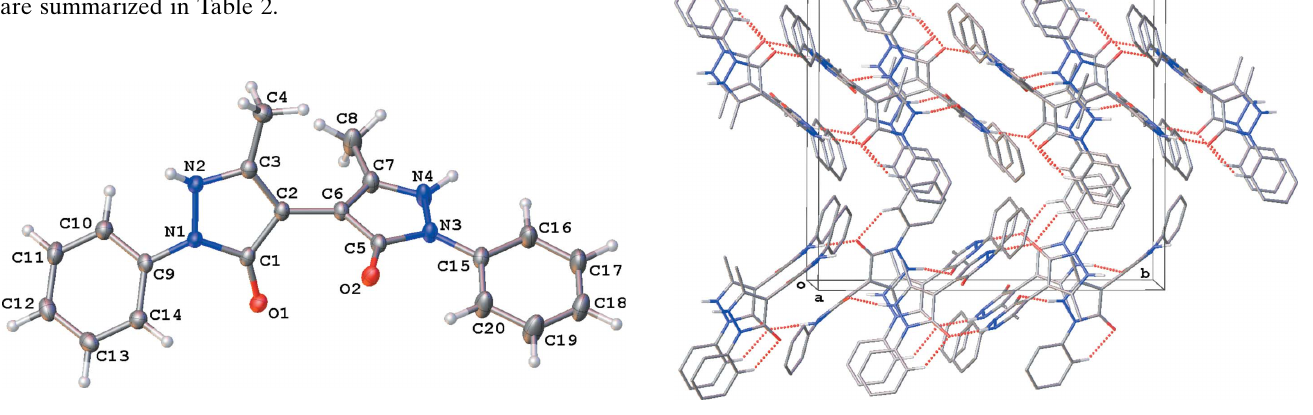
Figure 3 Packing of the molecules viewed approximately along the a axis with hydrogen bonds shown as dotted lines.